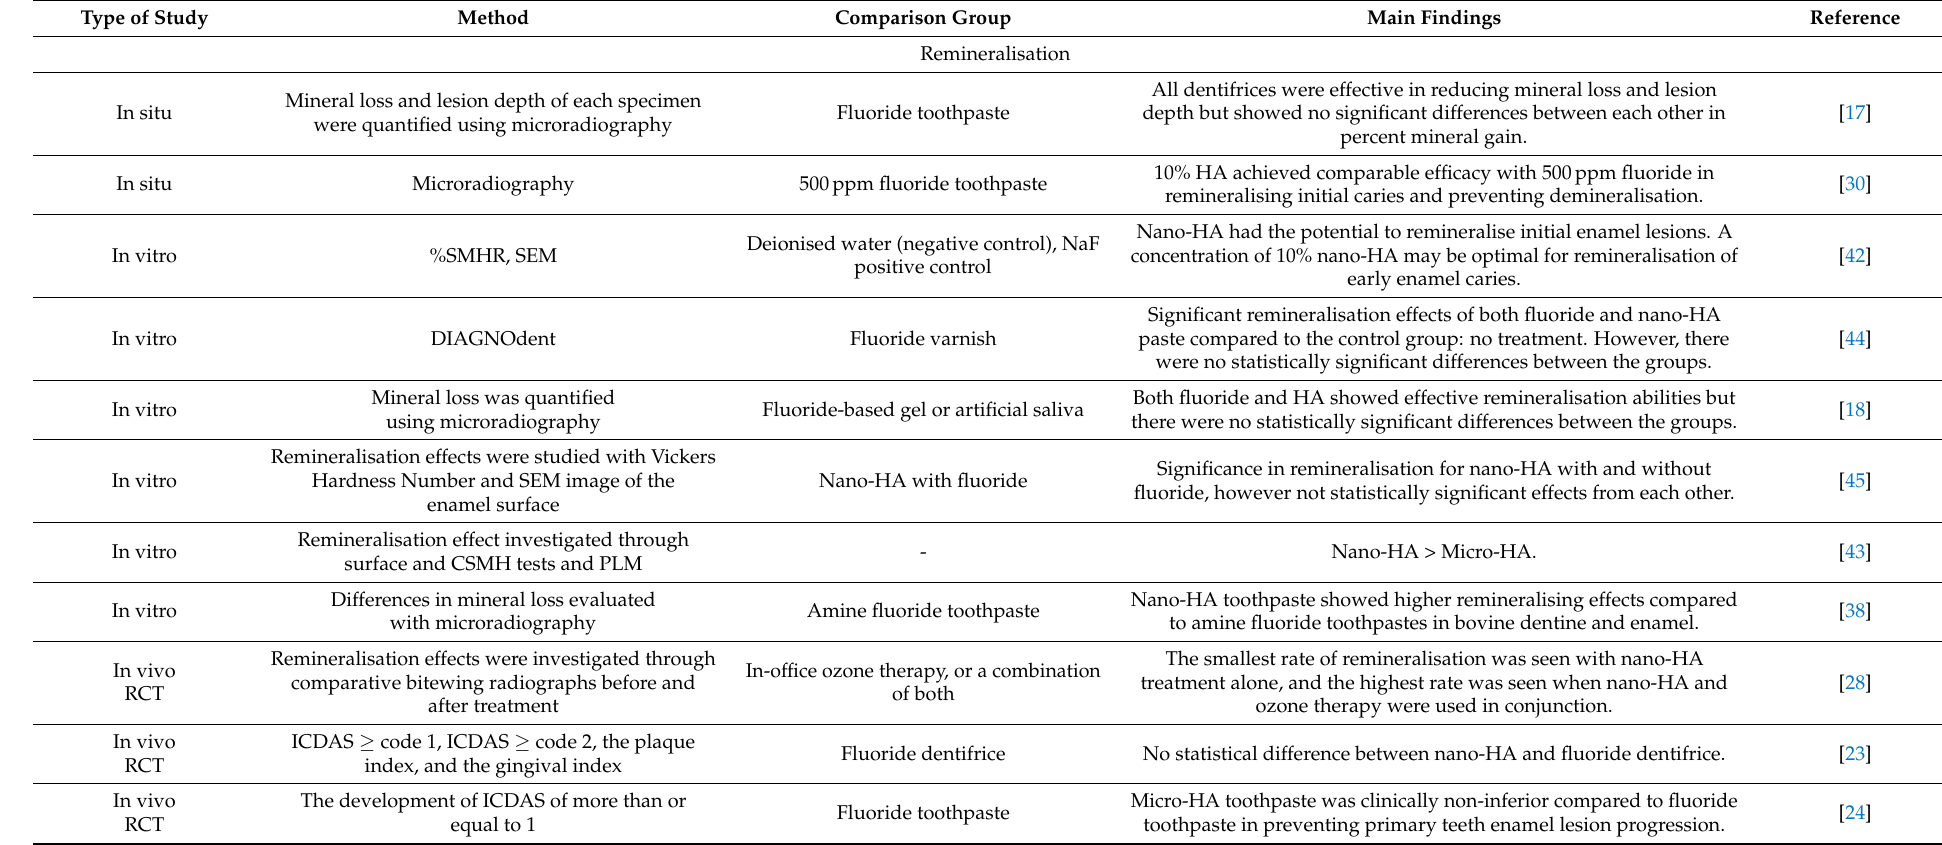
Table 2. Studies conducted on the claims of HA oral care